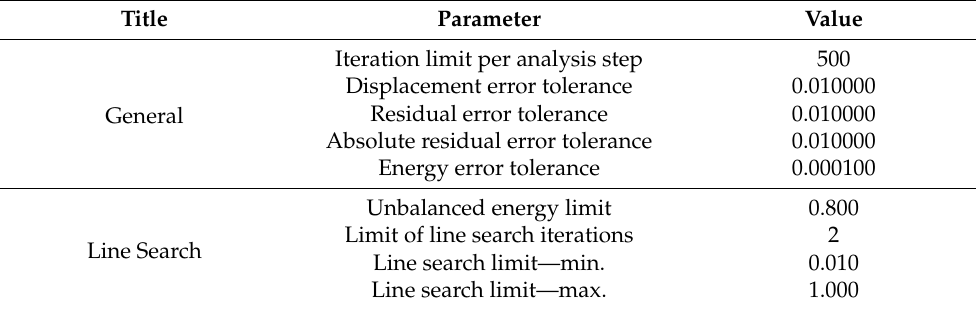
Table 8. Solution parameters.